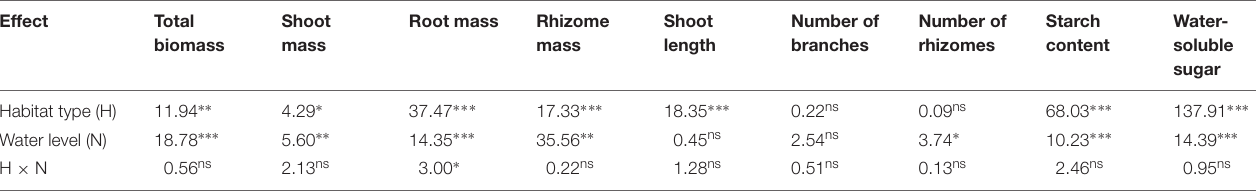
TABLE 1 | Summary of two-way analysis of variance ( F -values) for shoot mass, root mass, rhizome mass, and total biomass; shoot length; branch and rhizome numbers; and the contents of soluble sugar and starch in P. hydropiper from two habitat types under four water levels.